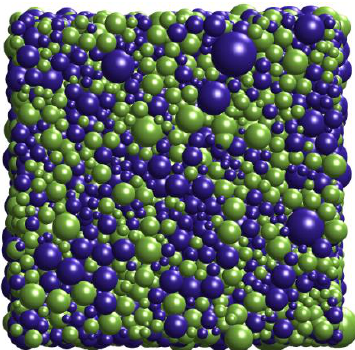
Figure 2. The RCPS (random close packing of spheres) model of PZT matrix ferroelectric composites (blue particles are PZT, and green particles are ferrite).